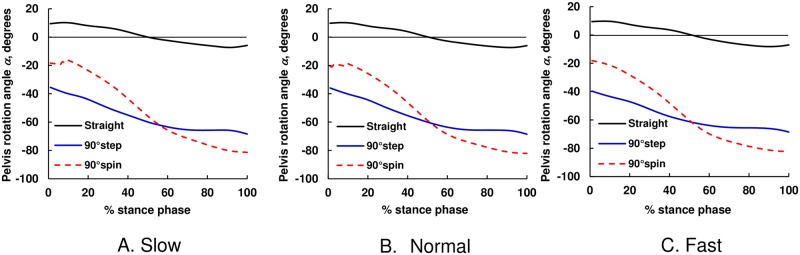
The average temporal pattern of the mean pelvis orientation angle during straight walking and turning.The black solid line shows straight walking, blue solid line shows 90° step turns, and red dashed line shows 90° spin turns. Note that the pelvis rotation angle for straight walking trials was adjusted for the right foot landing on the 2nd force plate. (A) Slow, (B) Normal, and (C) Fast.